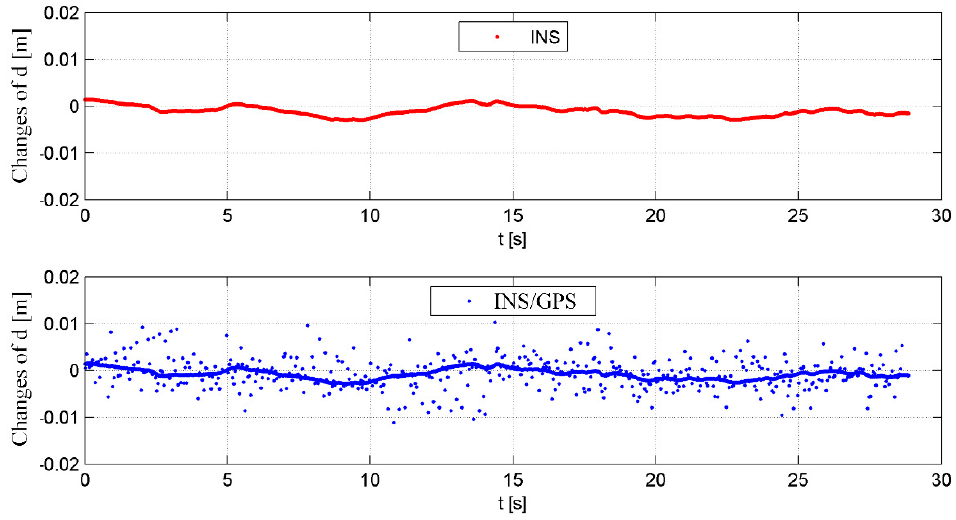
Figure 18. A comparison of changes of the vertical component of the unmanned aerial vehicles (UAV) position vector in one measurement session for the INS and the INS/GPS systems.